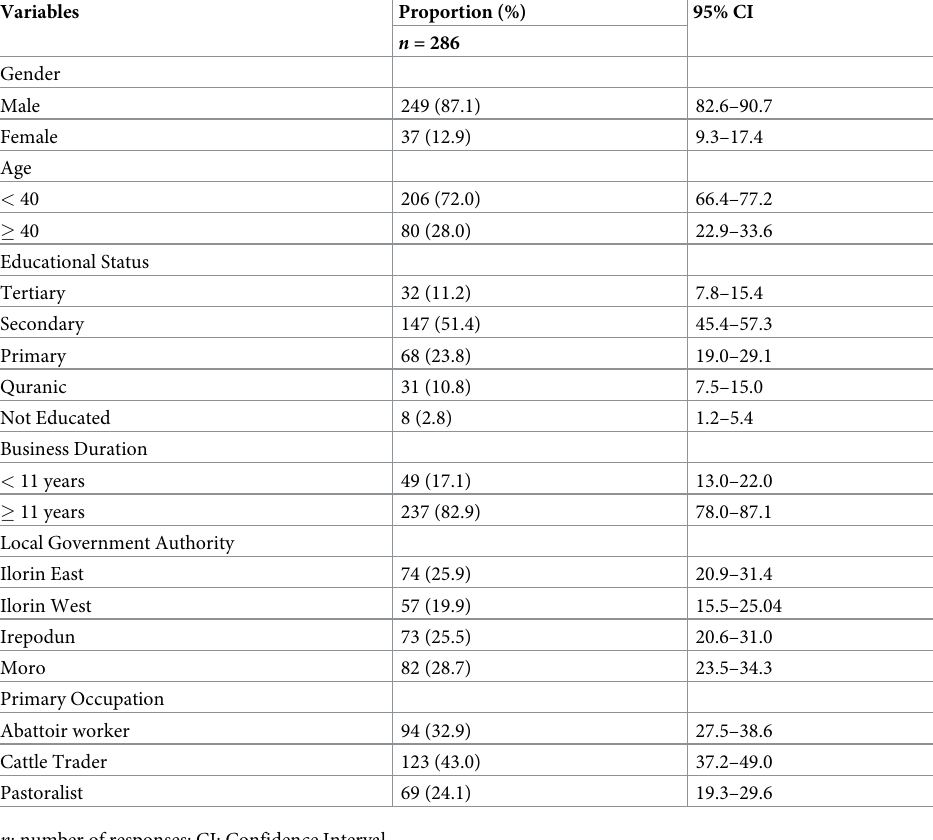
Table 1. Socio-demographic characteristics of